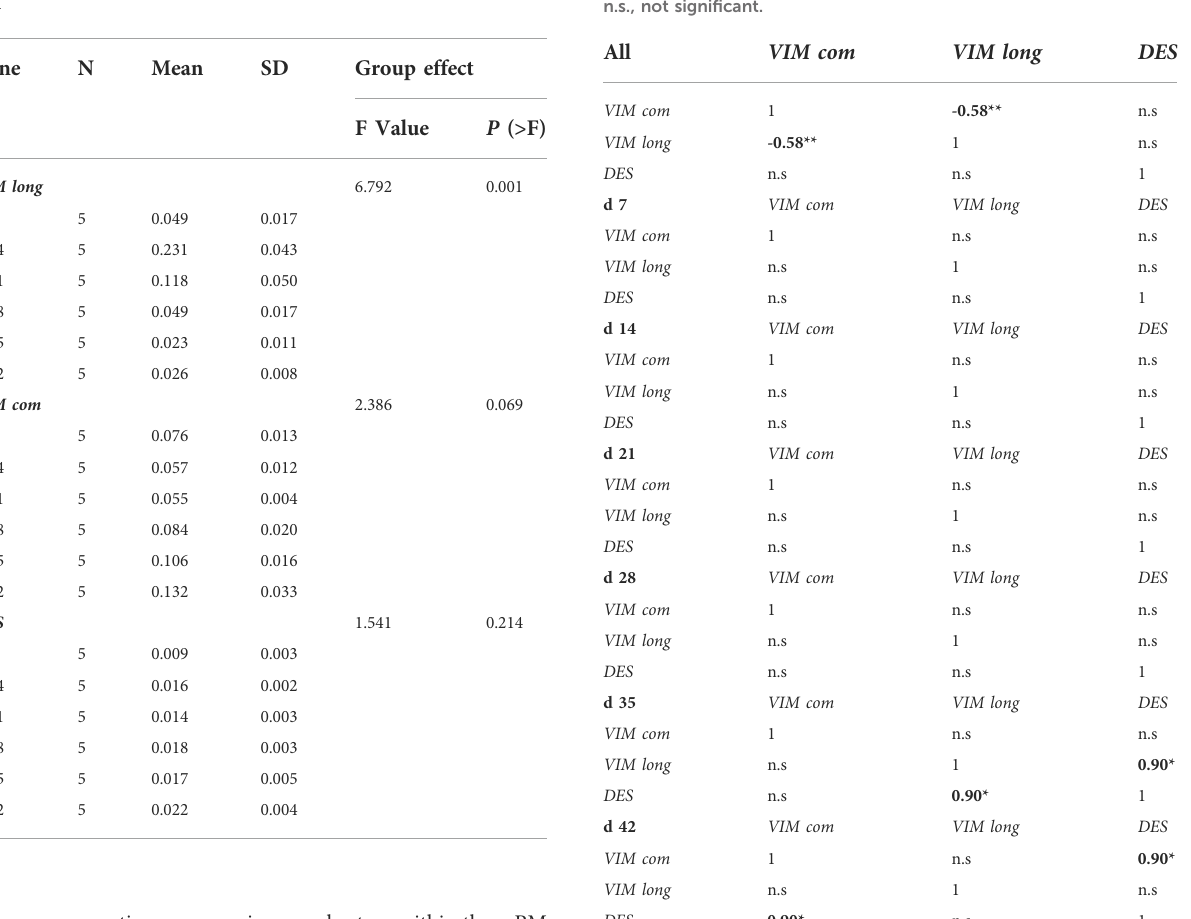
TABLE 2 Spearman ’ s correlations between the expression levels of VIM common sequence ( VIM com ), VIM long-isoform ( VIM long ) and DES genes in FGbroilers considering allthe samplestogetherand each sampling time separately (d 7, d 14, d 21, d 28, d 35 and d